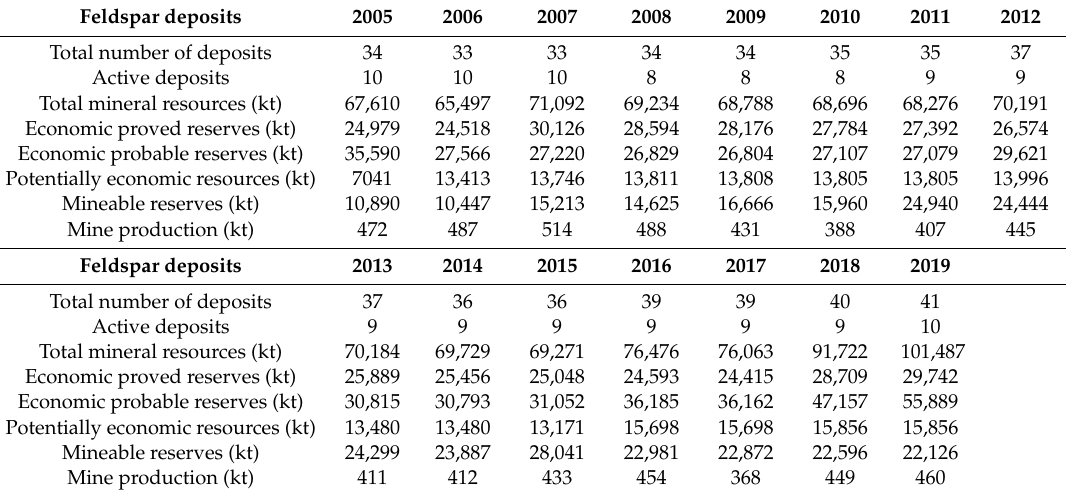
Table 4. Key data on feldspar in the Czech Republic